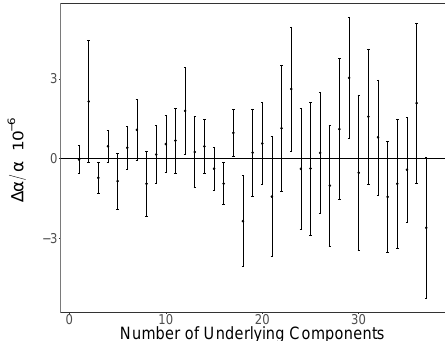
Figure 5. ∆ α / α vs number of underlying (real) velocity components for our sample of synthetic spectra. We created 37 synthetic spectra whose parameters were drawn from the minimum-AICc models for the z abs = 1.839 system towards J110325-264515 (analysed in [1]) for models that contained 1, 2, 3, ..., 37 velocity components. ∆ α / α is set to zero in these simulations. We applied Bayesian Model Averaging, BMA, to the large set of models generated by GVPFIT to estimate ∆ α / α for each of the 37 synthetic spectra. The statistical uncertainties are determined from the diagonal terms of the covariance matrix at the best-fitting solution.